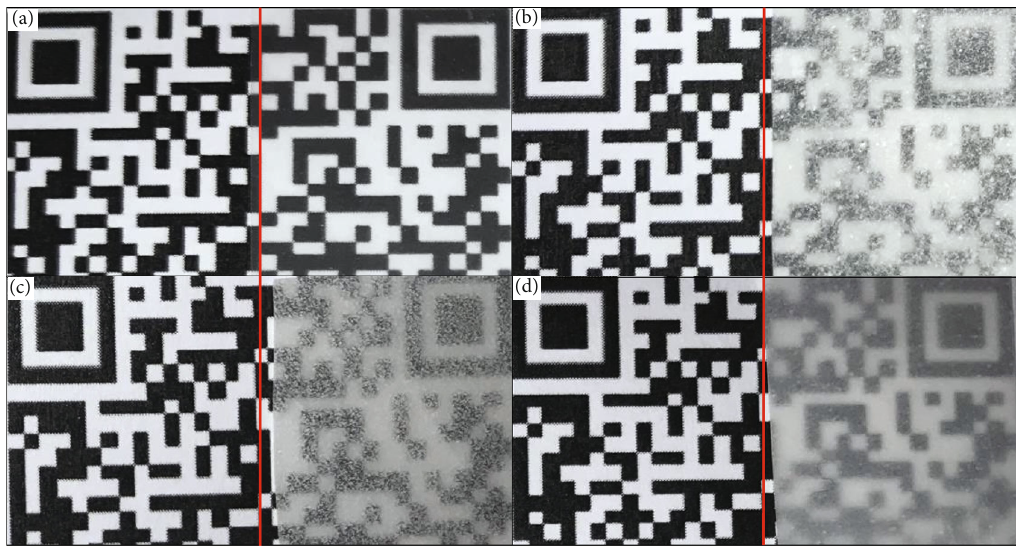
Figure 1: Images of PHB/S/LA overlaid on the right side (separated by red lines), demonstrating the translucency of the fi lms. (a) Pure PHB, (b) LA0, (c) LA1, and (d) LA2. The fi lm thickness of each sample was 70 : 0 ± 20 : 0 μ m